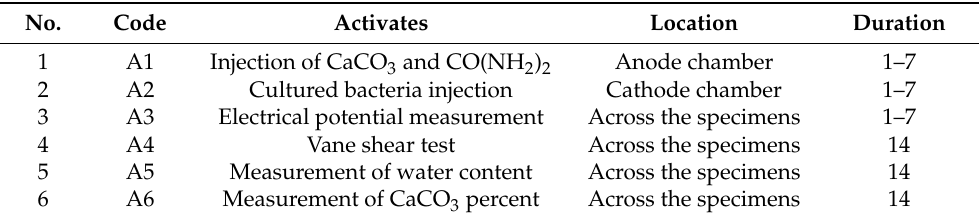
Table 3. Test procedure